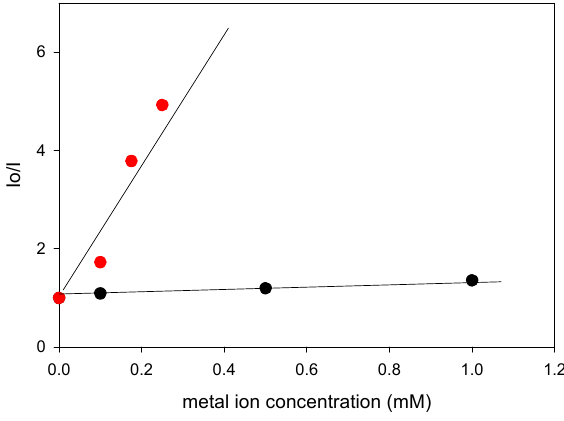
Figure 6. Stern–Volmer quenching plots of 9-anthracenemethanol in the presence of Fe 3+ (red circles) and Cu 2+ (black circles).